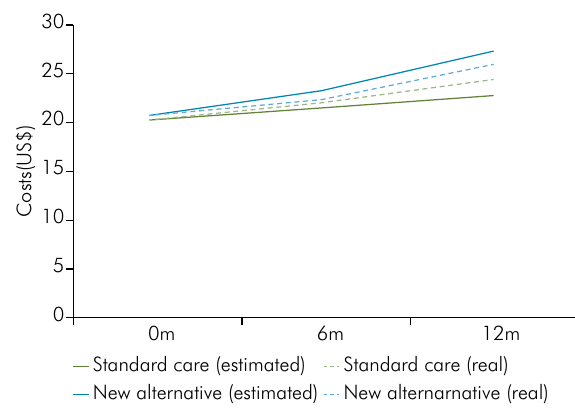
Figure 4. Comparison of estimated (simulating the absence of long-term cost data) and real cost values in a trial-based economic